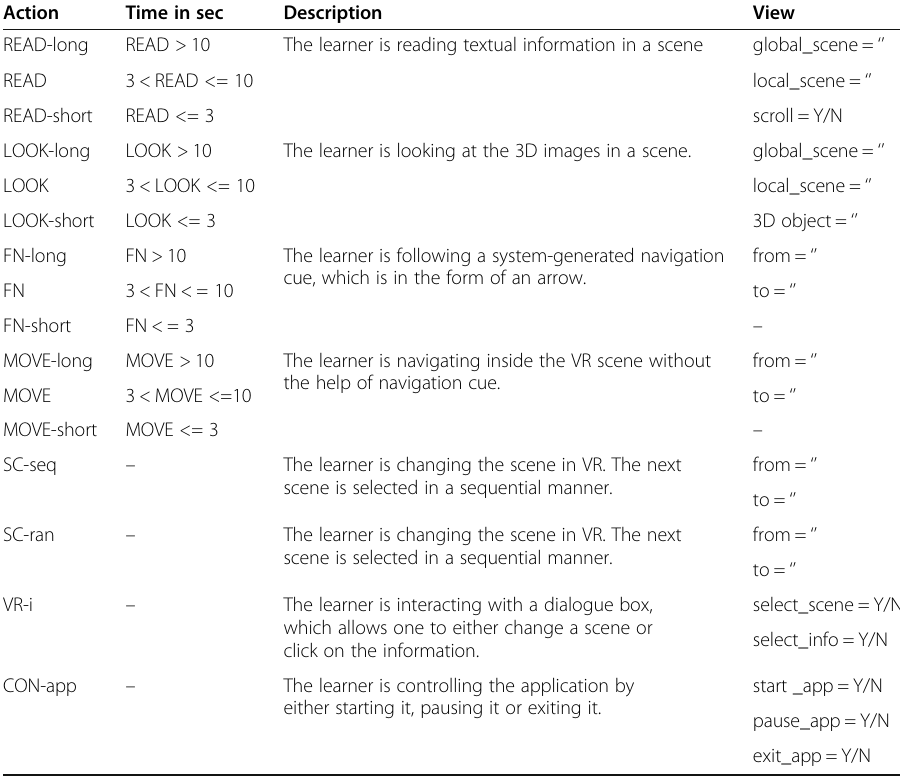
Table 1 Learner actions and contextual details